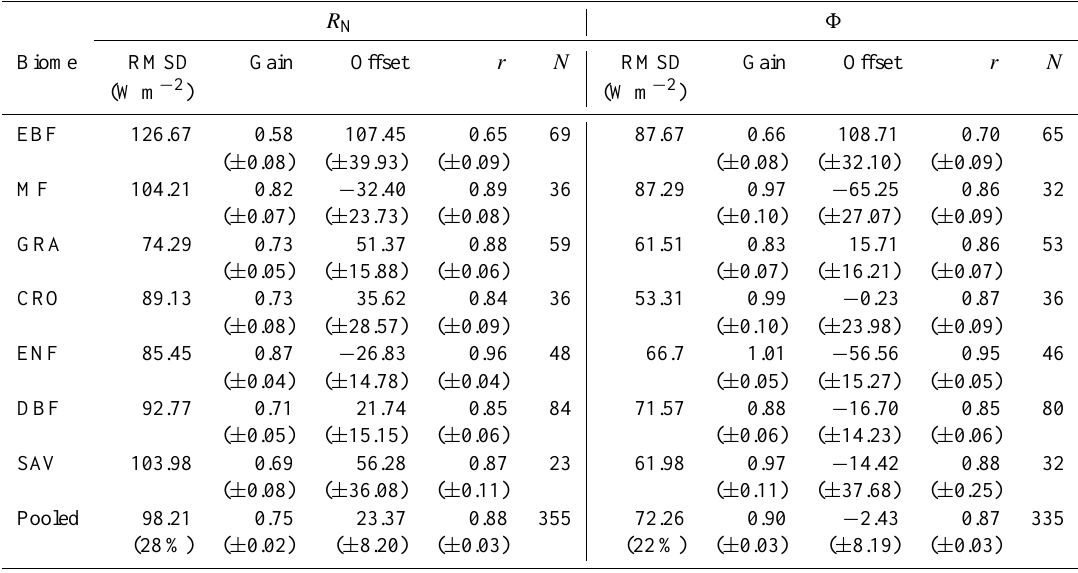
Table 3. Comparative statistics for the satellite- and tower-derived monthly midday (13:30LT) R N and (cid:56) for a range of biomes. Values in parenthesis are ± 1 standard deviation.